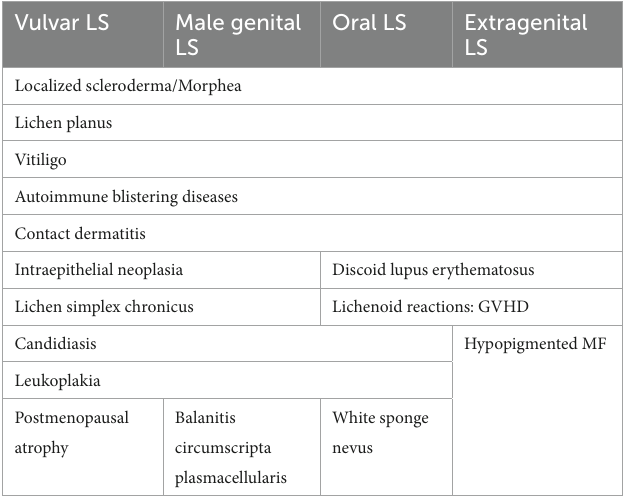
TABLE 4 Summary of clinical differential diagnoses in lichen sclerosus (LS) (13). Vulvar